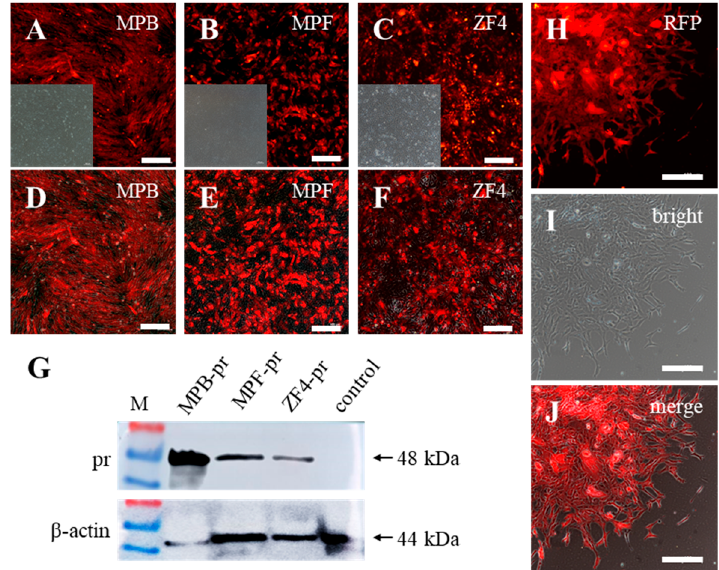
Figure 3. Expressions of RFP in stably integrated fish cell lines. ( A – F ) Expression of RFP in stable MPB, MPF, and ZF4 cells after baculovirus transduction and drug selection. ( A – C ) are images caught at red fluorescence and bright. ( D – F ) are merged images. ( G ) Western blot results of Puromycin-RFP (Pr) protein (48 kDa) in stably transduced MPB, MPF, and ZF4 and un-transduced control cell lines. M represents protein markers. ( H – J ) Monoclonal cell growth assay of stably transduced MPF cells. The expression of RFP was observed under an inverted fluorescence microscope. Scale bars, 200 μ m.